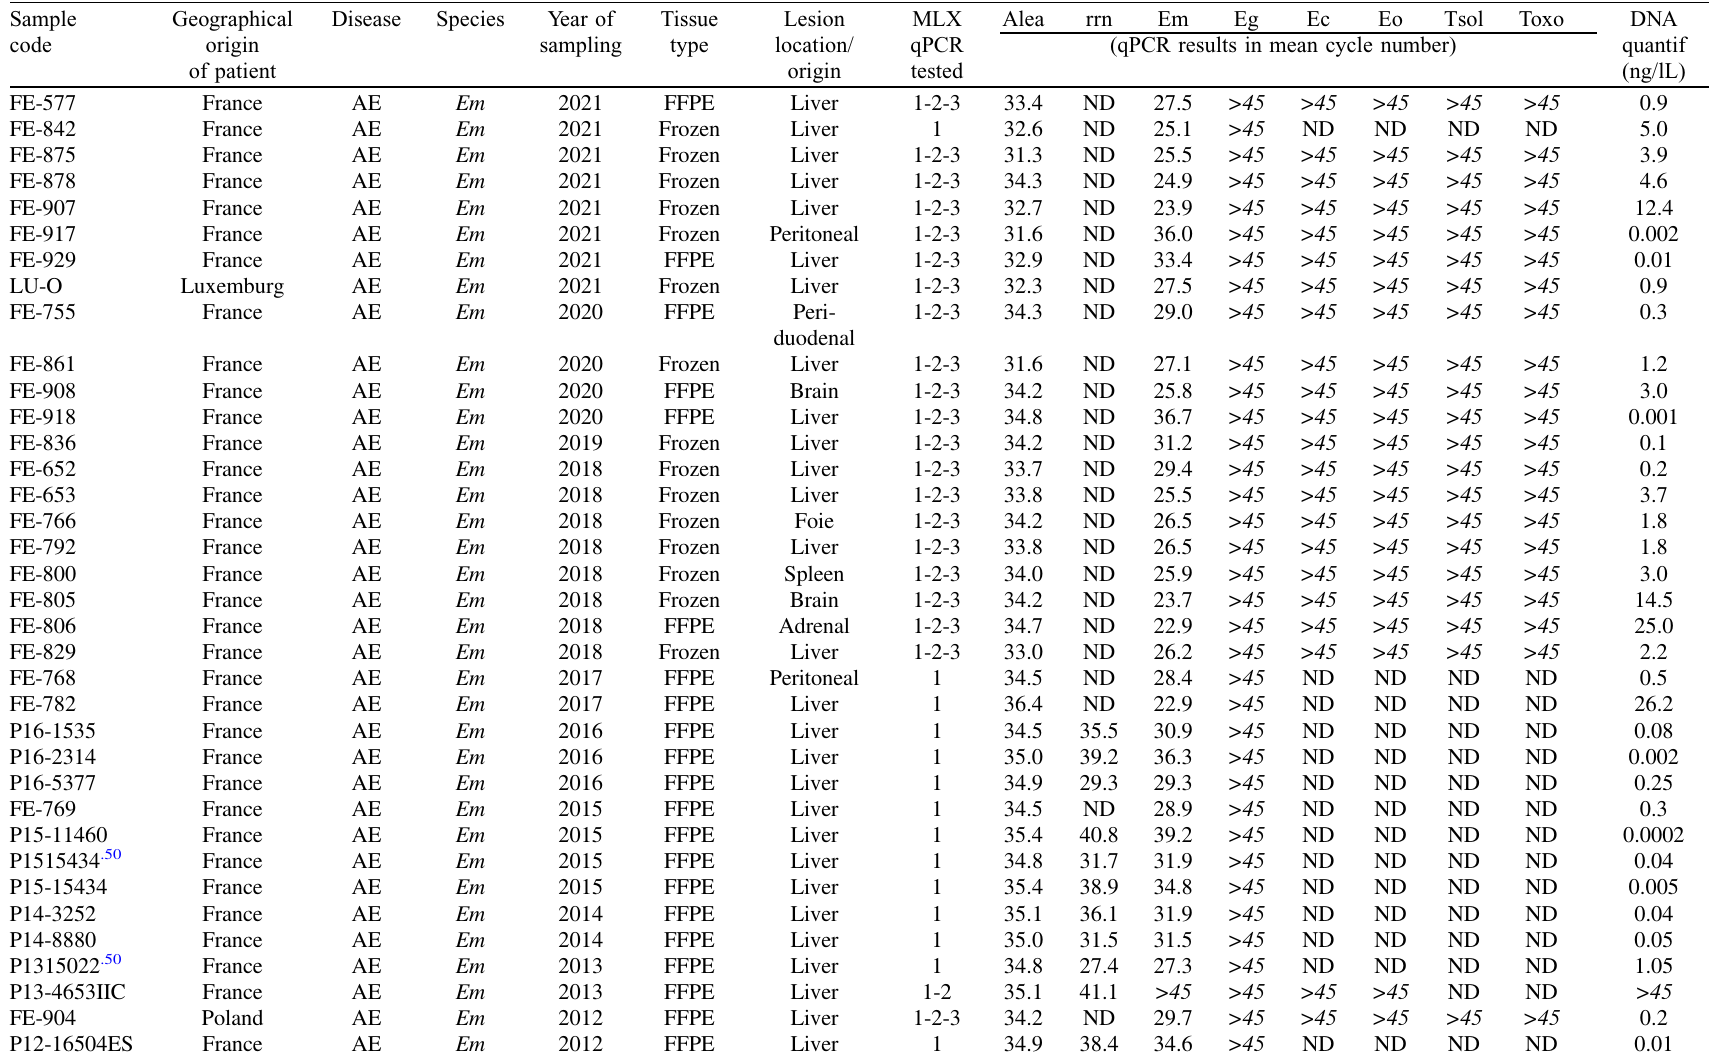
Table 1. Collection of alveolar and cystic echinococcosis lesion samples stored fresh or frozen or as formalin- fi xed paraf fi n-embedded (FFPE) samples and qPCR results (Cq value and DNA concentration assessment) for the